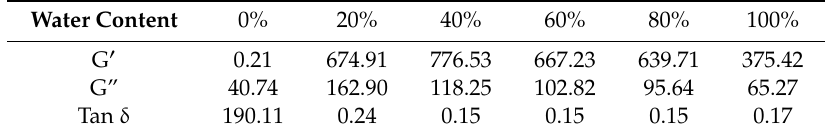
Figure 4. Strain sweep ( a ) and frequency sweep ( b ) curves of the xanthan gum-based eutectogels with different water contents and hydrogel. Table 1. Tan δ values for eutectogels with different water contents measured at 1 Hz of frequency.